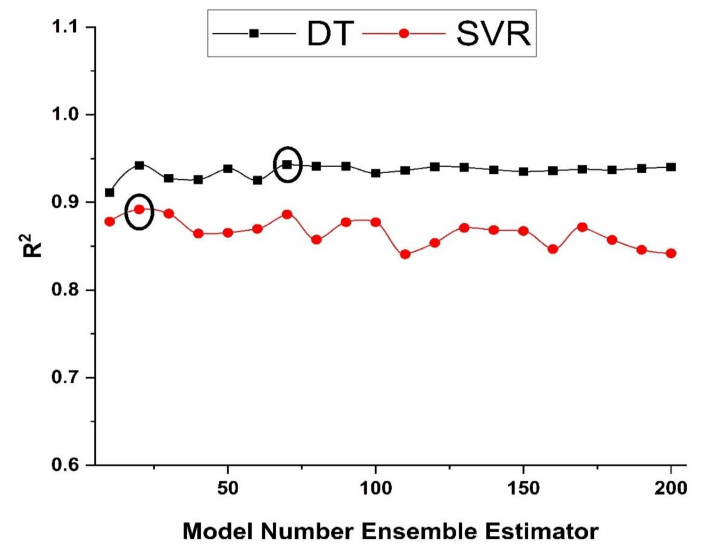
Figure 6. Coefficient of determination for ensemble models with the various number of component sub-models for compressive